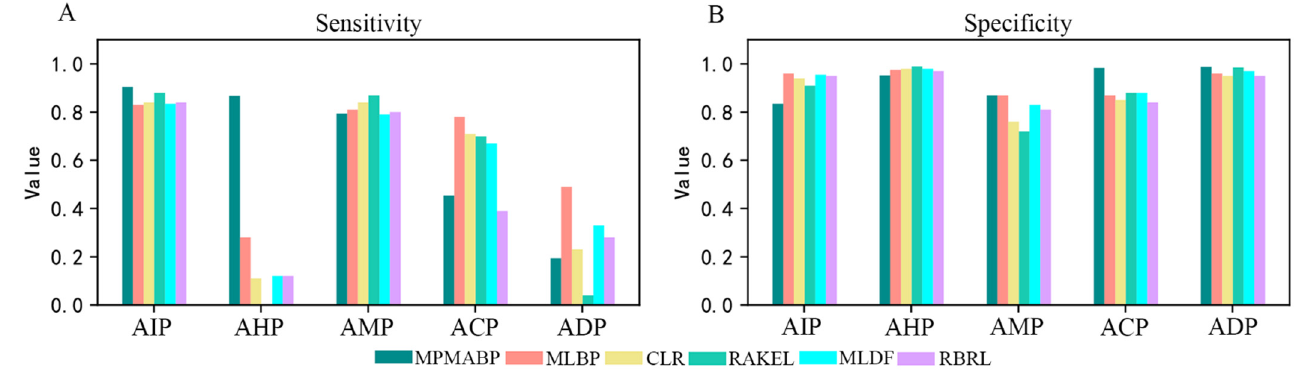
Figure 2. The predictive performance of single-functional bioactive peptides. (A) Comparison of MPMABP with other methods on SN, (B) Comparison of MPMABP with other methods on SP. Table 4. Comparison with four existing state-of-the-art methods.